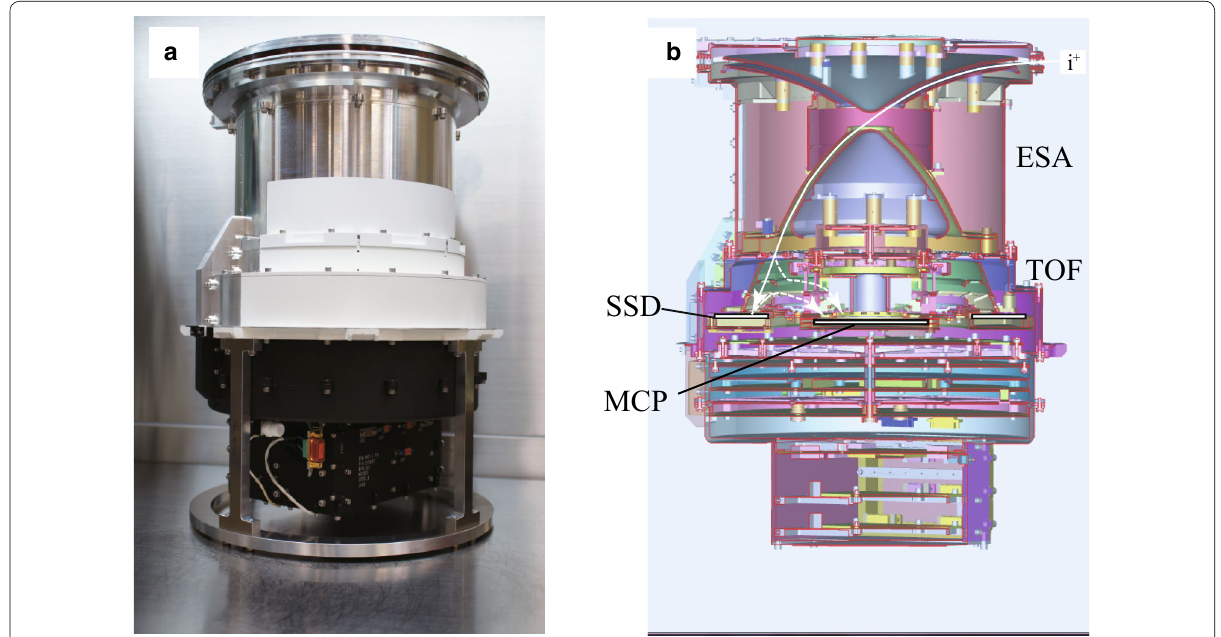
Fig. 1 a Photograph and b cross-sectional view, of the MEP-i flight model. The anti-sunward side of the analyzer is whitened for heat radiation. Trajectories of incident ions (solid curve) and secondary electrons (dotted curves) are shown in the cross-sectional